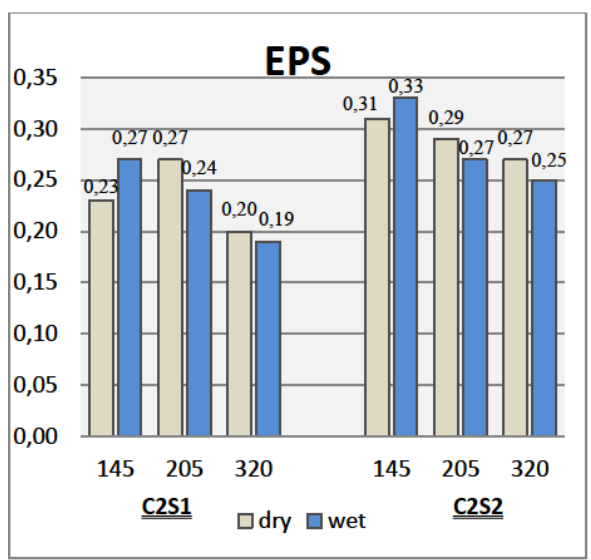
Figure 6: Average results of the pull-off method; comparing the